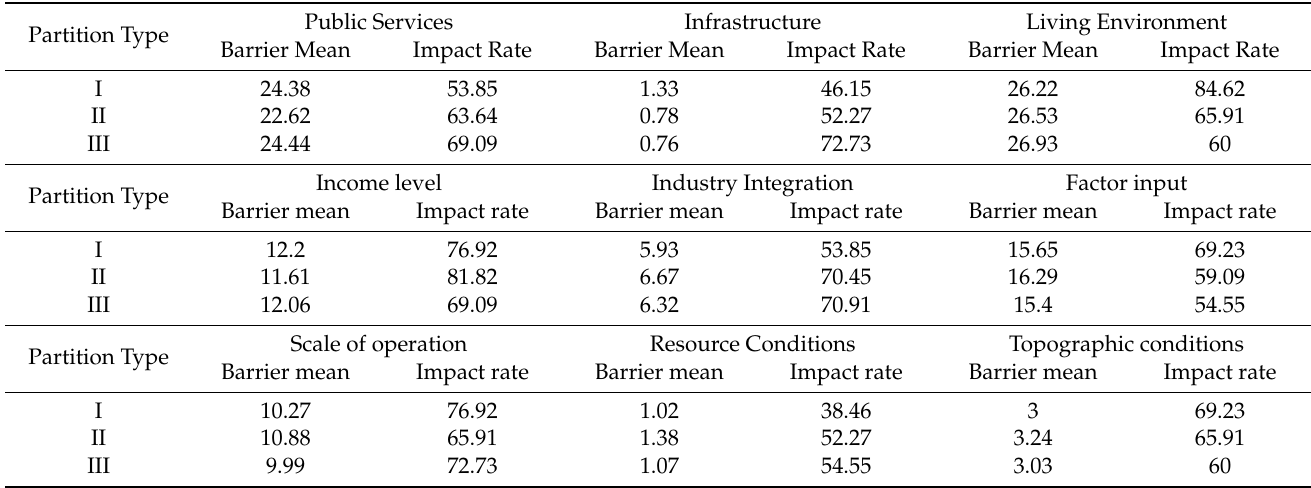
Table 4. Means of barriers and impact rate results of different rural multi-function development zones